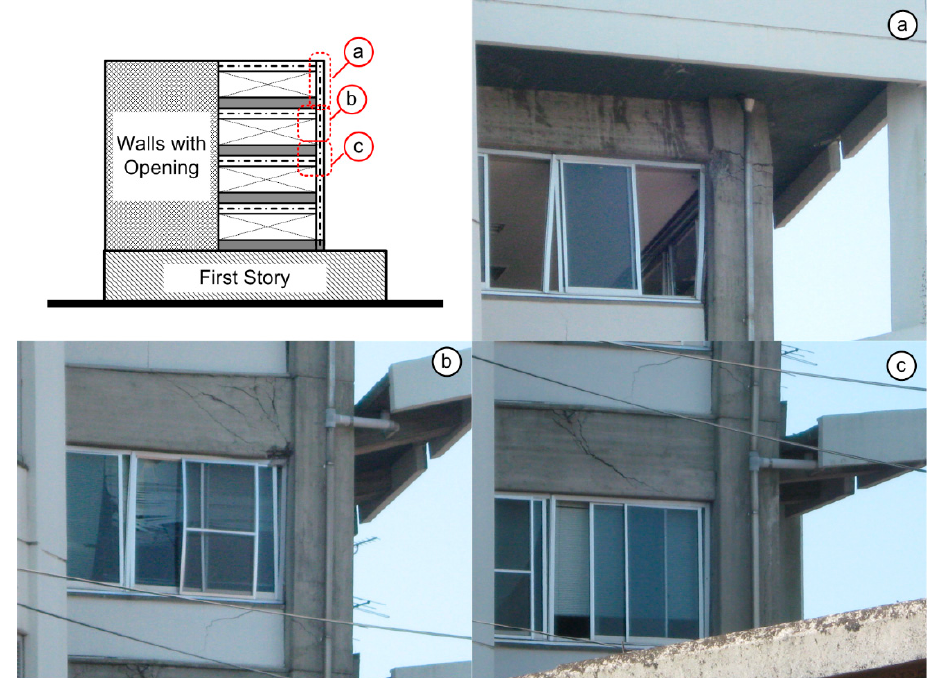
Figure A5. Simplified elevation and photographs of the north elevation. Photographs show damage to ( a ) the top of corner columns and beams on the roof floor, ( b ) a beam on the fifth floor, and ( c ) the bottom of a fourth-story column and a fourth-floor beam.